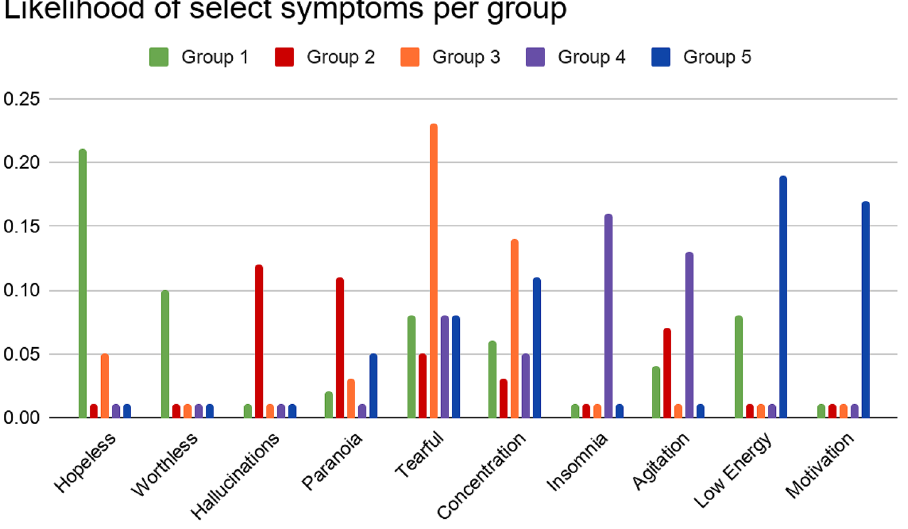
Figure 1. Probabilities of symptoms per patient group. The top two most likely symptoms per group were included.